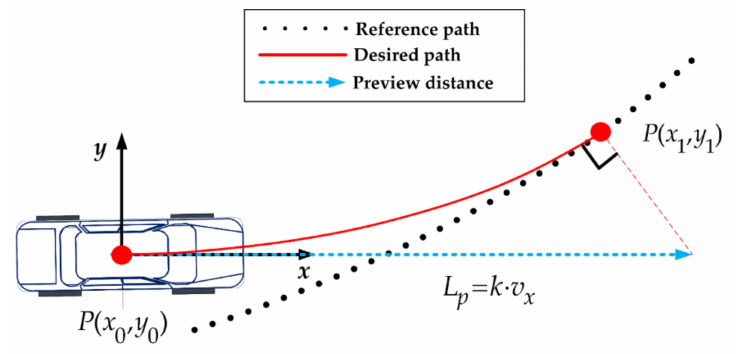
Figure 3. Desired path decision based on the